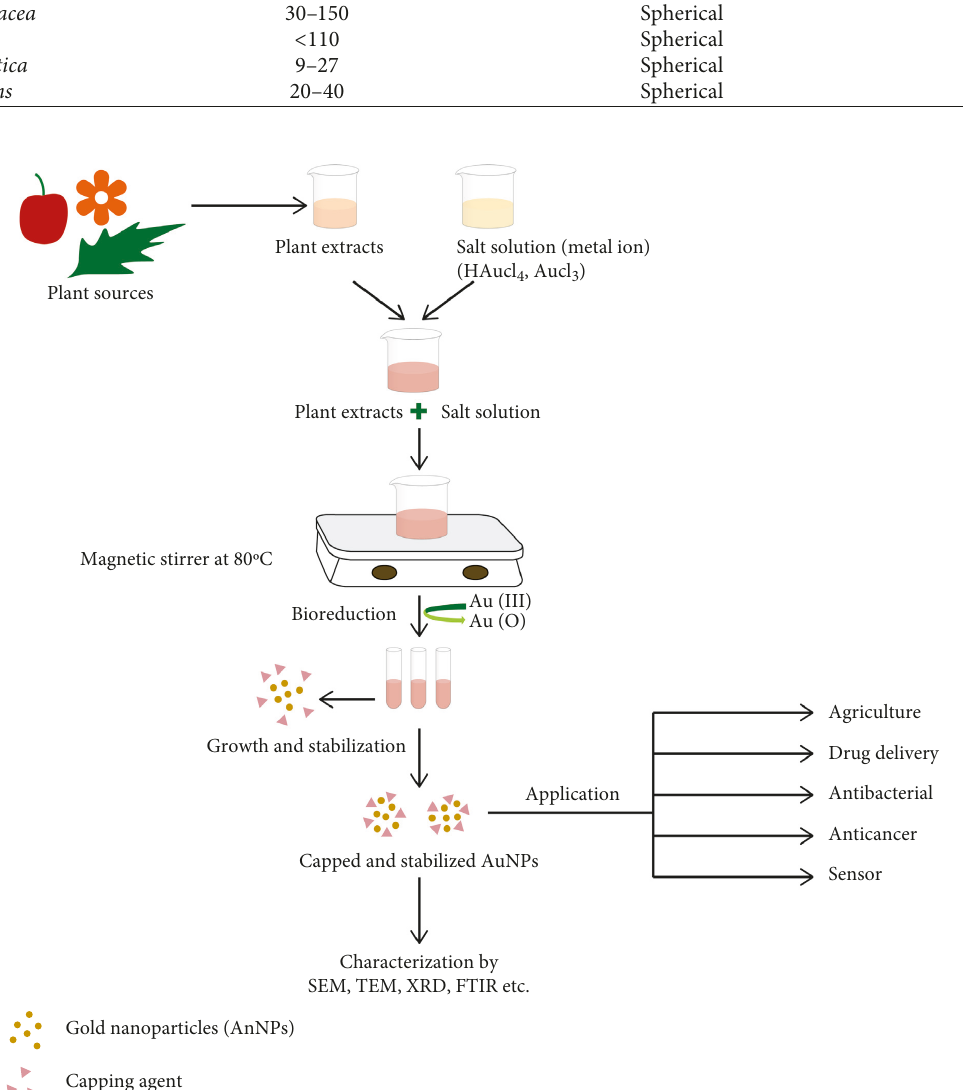
Figure 3: Green synthesis of GNPs from a plant